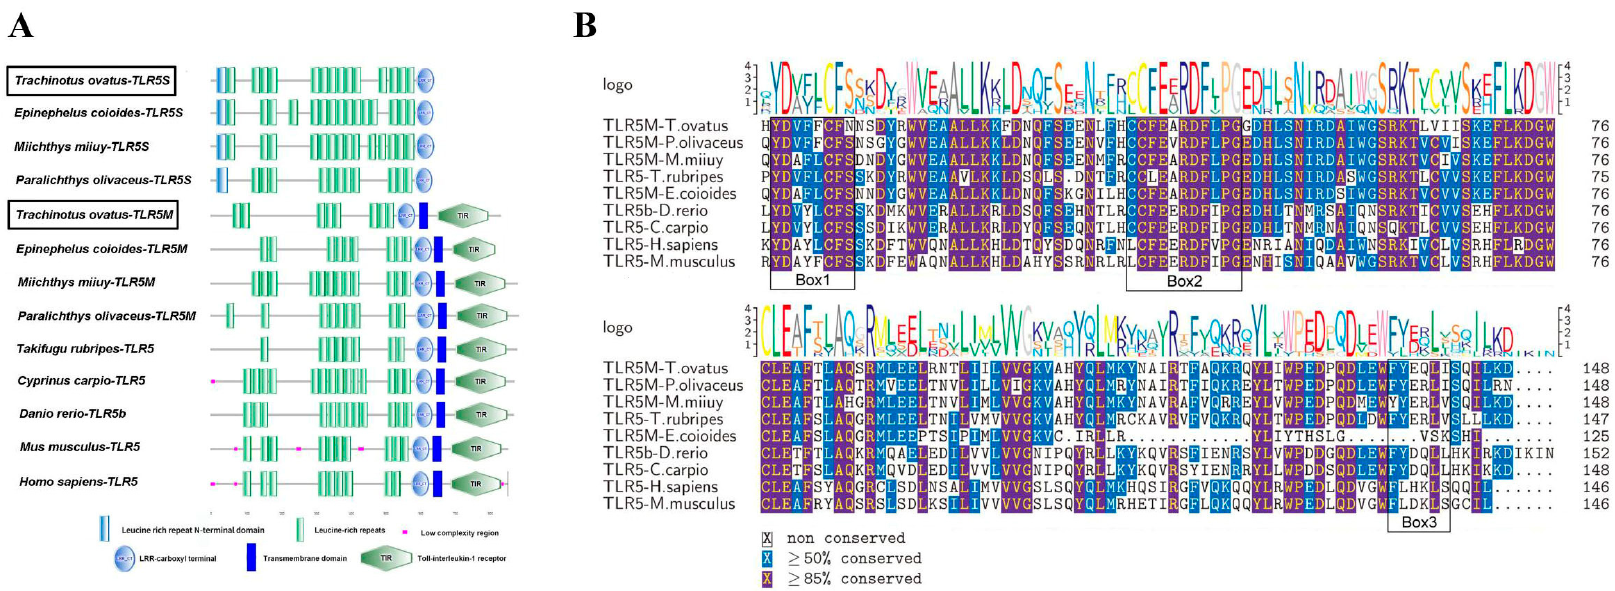
Figure 2. The domain features of the membrane form of TLR5 (TLR5M) and the soluble form of TLR5 (TLR5S) among vertebrates. ( A ) Multiple alignment of TLR5 deduced amino acid sequences. LRR represents leucine-rich repeats, red represents low-complexity region, LRR-CT represents LRR C-terminal region, blue represents transmembrane region, TIR represents Toll / interleukin-I receptor domain. ( B ) The amino acid sequence alignment of TLR5 TIR domains in various species. The GenBank accession numbers are shown in Table S1.